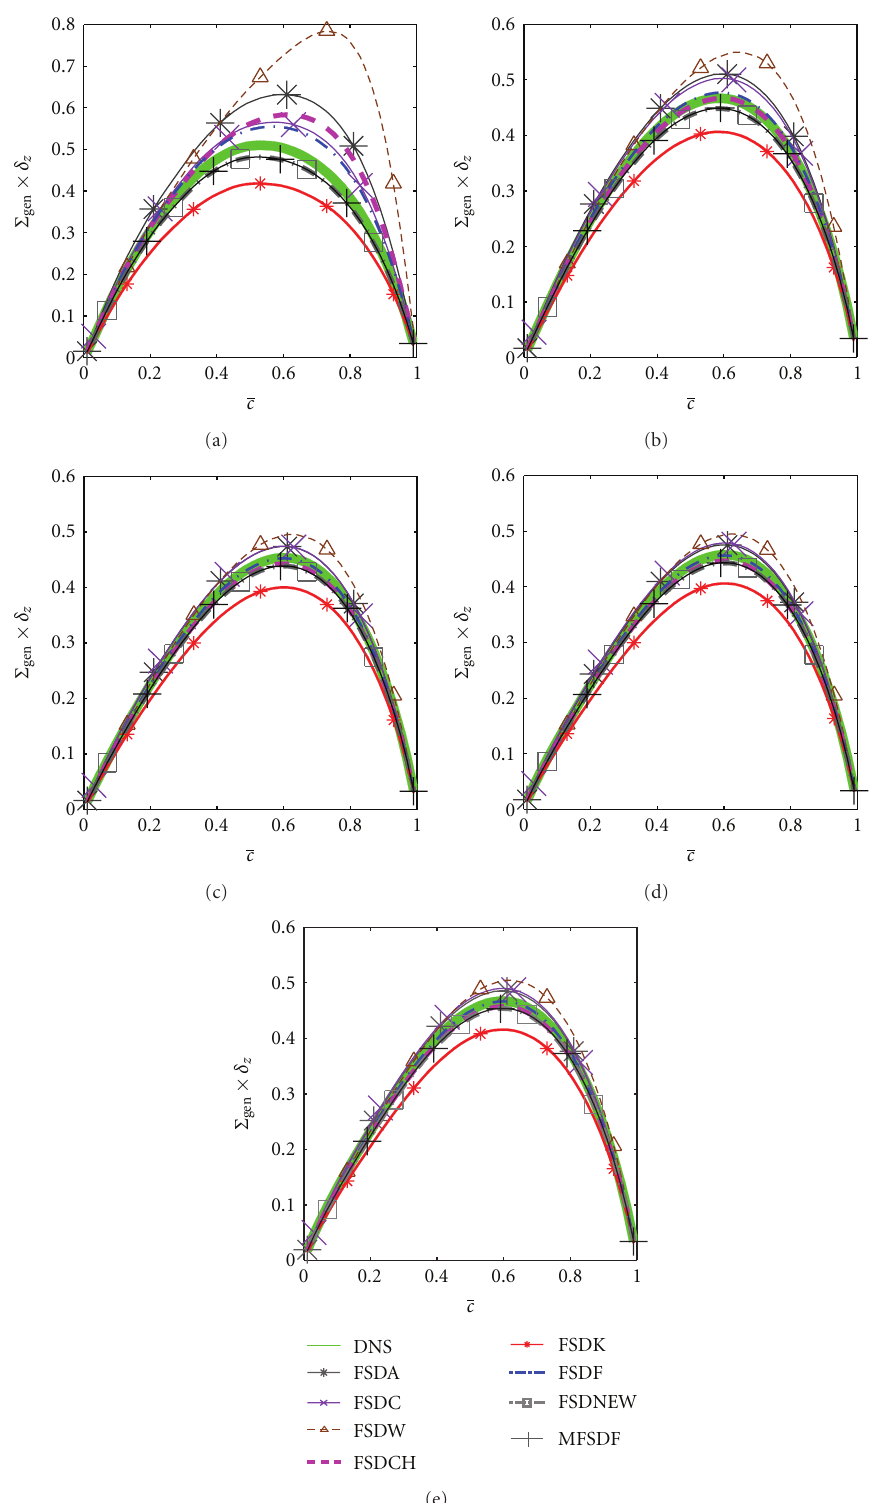
Figure 4: Variation of mean values of Σ gen × δ z conditional on c across the flame brush for Δ = 8 Δ m = 0 . 8 δ th according to DNS, FSDA, FSDC, FSDW, FSDCH, FSDK, FSDF, FSDNEW, and MFSDF predictions for (a–e) cases